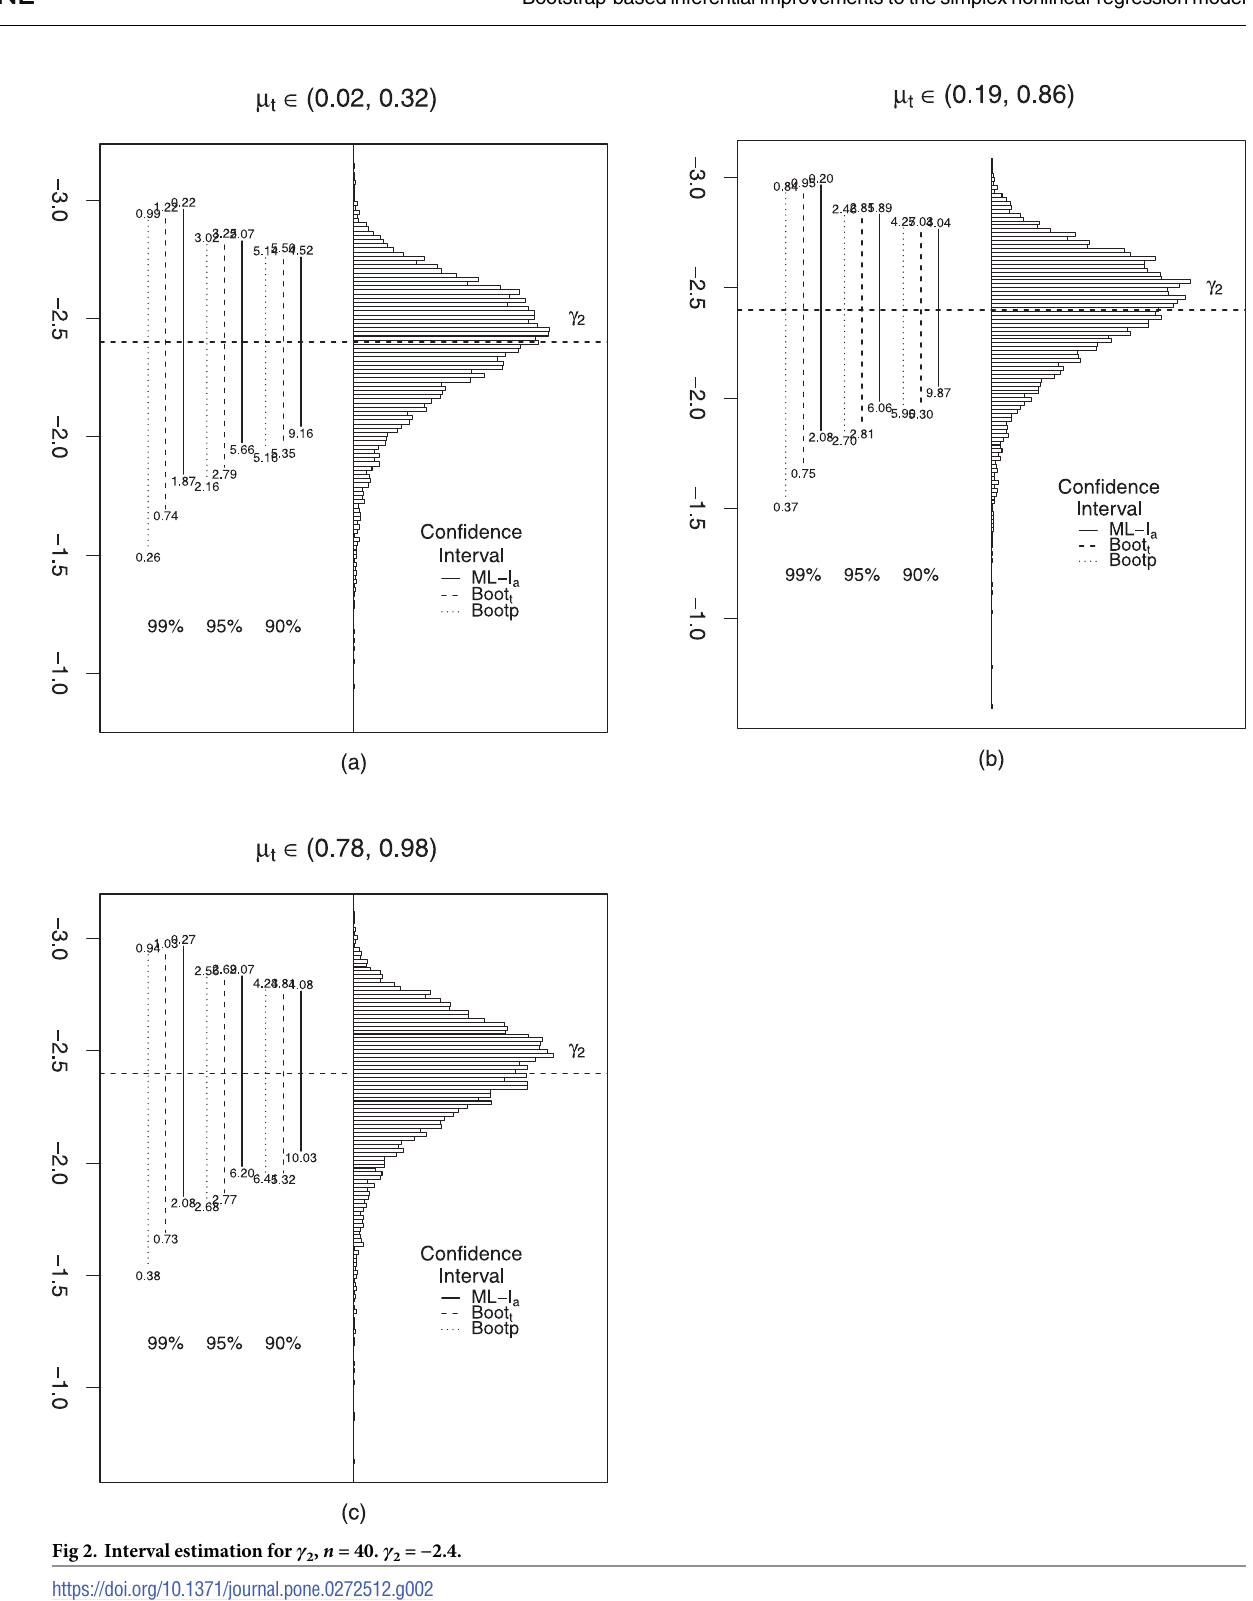
PLOS ONE | https://doi.org/10.1371/journal.pone.0272512 August 9,